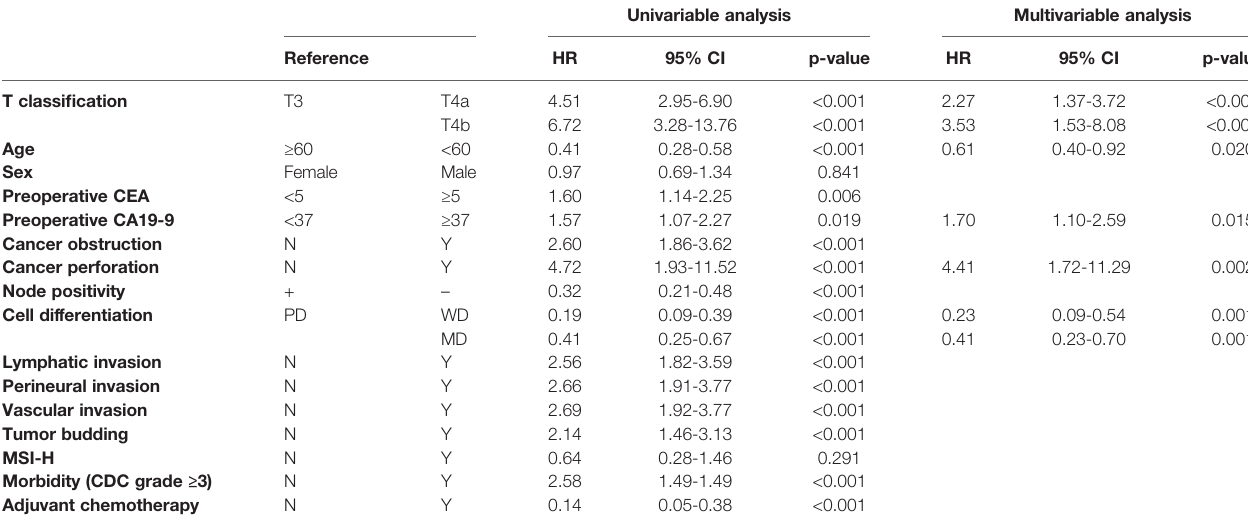
TABLE 4 | Univariable and multivariable cox regression analysis of cancer-speci fi c survival.